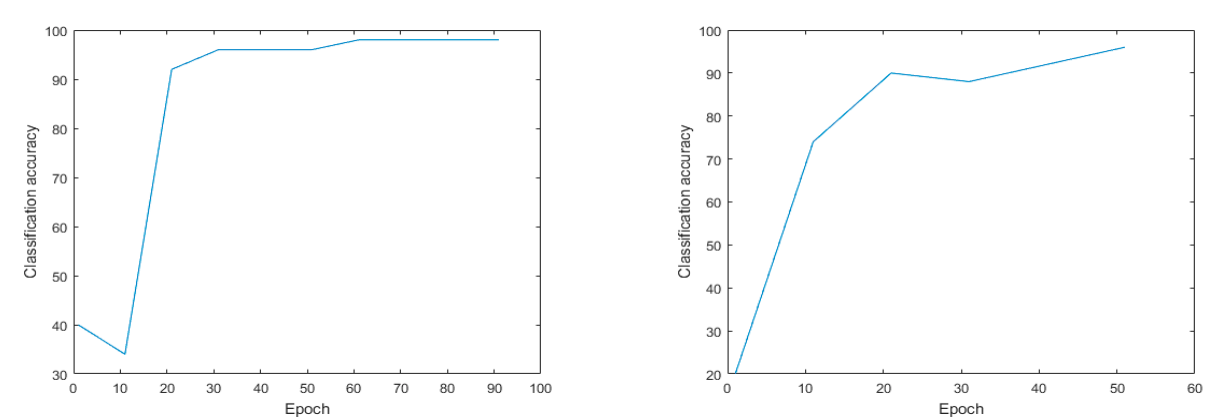
Figure 4. Number of iterations and classification accuracy of SAE model. Note: The accuracy after 100 iterations was 98.25% and the average error was 1.75%; after 55 iterations the accuracy rate was 94.82% and the average error was 5.18%.